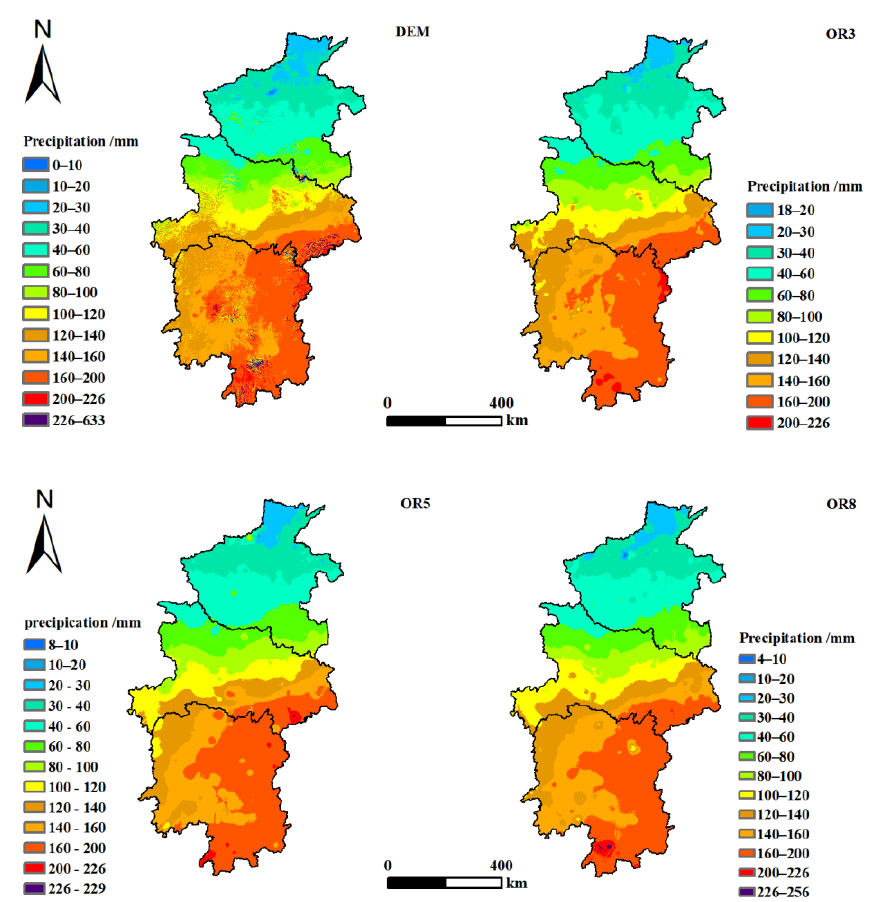
Figure 7. Water simulation results of topographic drop in Central China at various scales.